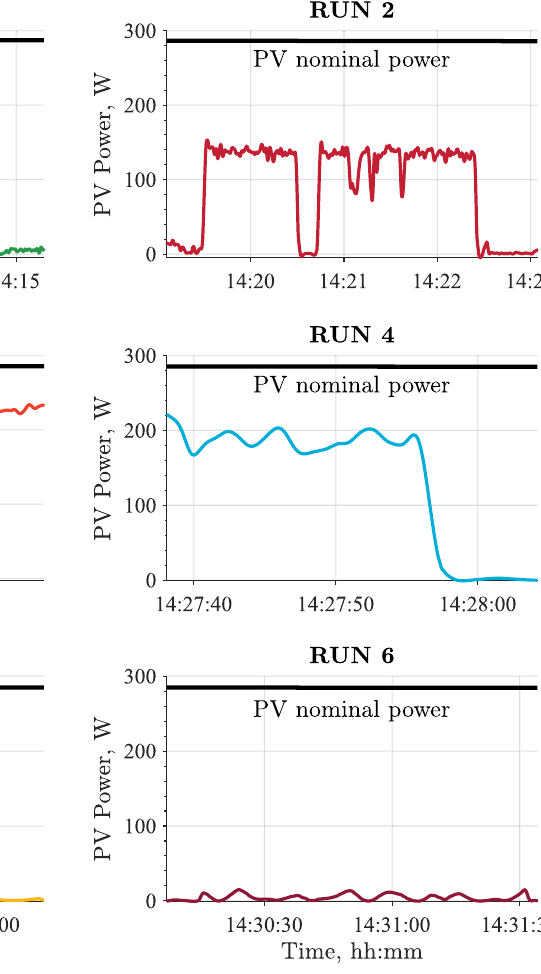
Fig. 10 Collected PV power during the navigation tests. Run 1: FWD on a paved surface; Run 2: AWD on a paved surface; Run 3: FWD on a flat grass field; Run 4: AWD on a flat grass field; Run 5: AWD circu-